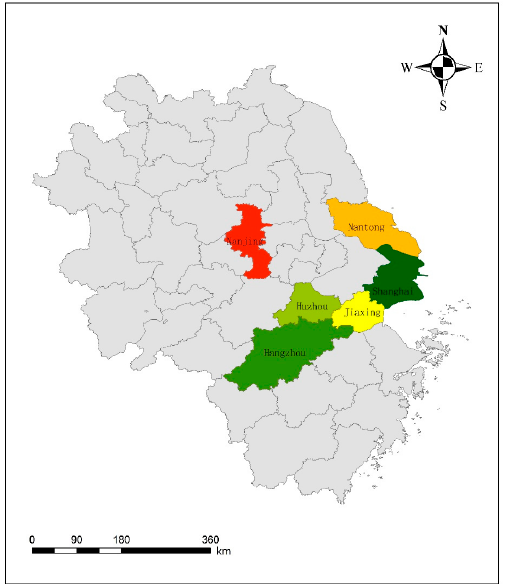
Figure 3. The scale of field investigation. Table 2. Stakeholder groups in the biomass energy industry in the Yangtze River Delta for in-depth interviews [23,46–48].